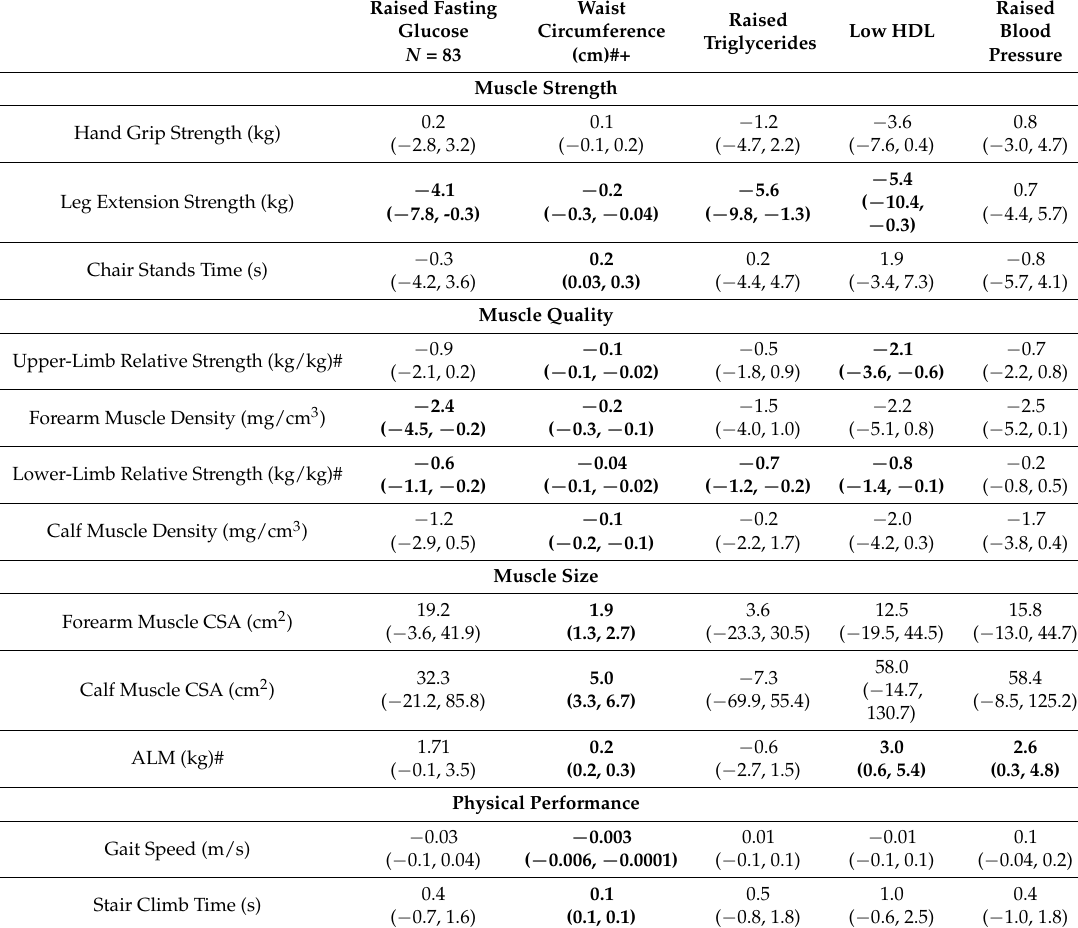
Table 4. Multivariable regression exploring associations between components of metabolic syndrome and sarcopenia.